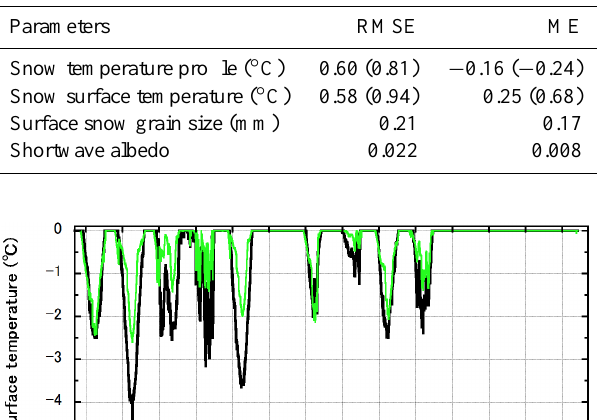
Table 1. Comparison of SMAP simulation results with in situ mea- surements. RMSE and ME are the root mean square error and mean error (the average of the difference between simulated values and observed values), respectively. Figures in parentheses indicate scores when the observed surface temperature was negative (i.e., dry snow conditions).